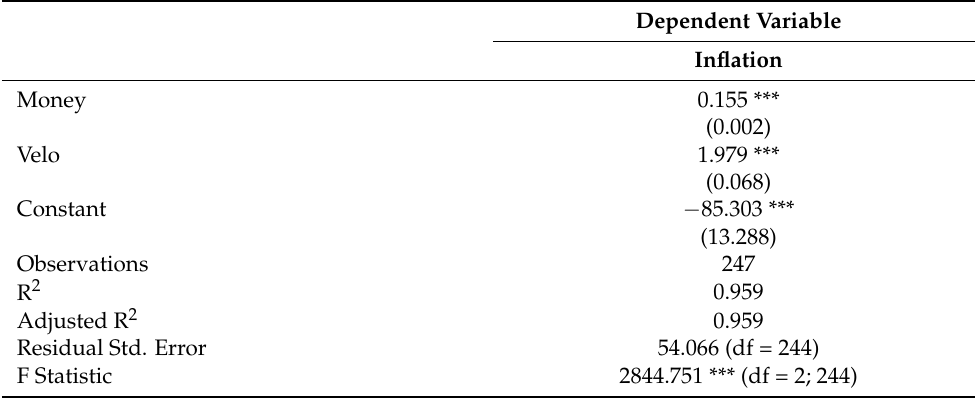
Figure 3. Historic data plot of quantity of money, velocity of money, GDP, and GDP deflator from 1 January 1960 to 1 July 2021. The color scale represents the change of the GDP deflator, with respect to inflation, in response to changes in the quantity of money, the velocity of money, and GDP (GDCP1).